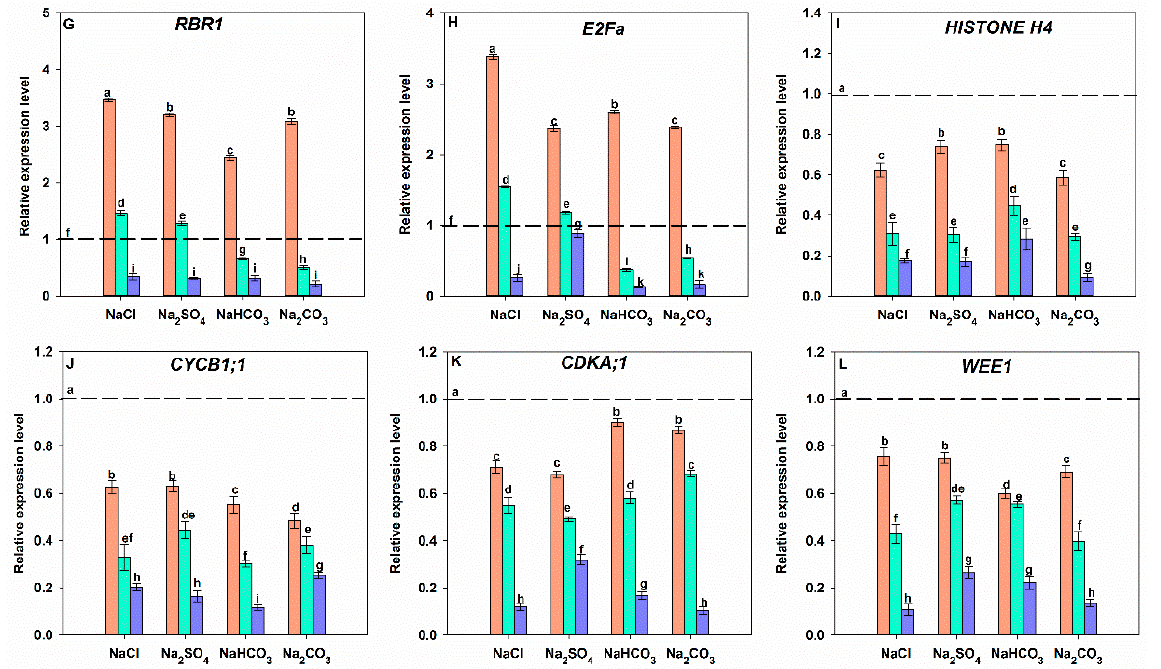
Figure 7. Relative expression levels of cell phase transition regulation/marker genes in soybean seedling roots treated with different salt stress conditions for 3 days. Relative expression levels of G1/S phase transition regulation/marker genes RBR1 , E2Fa , and HISTONE H4 ; G2/M phase transi- tion regulation/marker genes CYCB1;1 , CDKA;1 , and WEE1 in HH49 ( A – F ) and HN95 ( G – L ) seedling roots treated with different Na + concentrations solutions in formulas of NaCl, Na 2 SO 4 , NaHCO 3 , and Na 2 CO 3 . Gene expression levels of HH49 in ( A – F ) and HN95 in ( G – L ) seedling roots under normal conditions were set to 1 as the normalization for qRT-PCR analysis using the operational formula 2 − ∆∆ Ct and are indicated as dashed lines. Data are expressed as means ± SD. Different letters indicate statistically significant differences ( p < 0.05) among